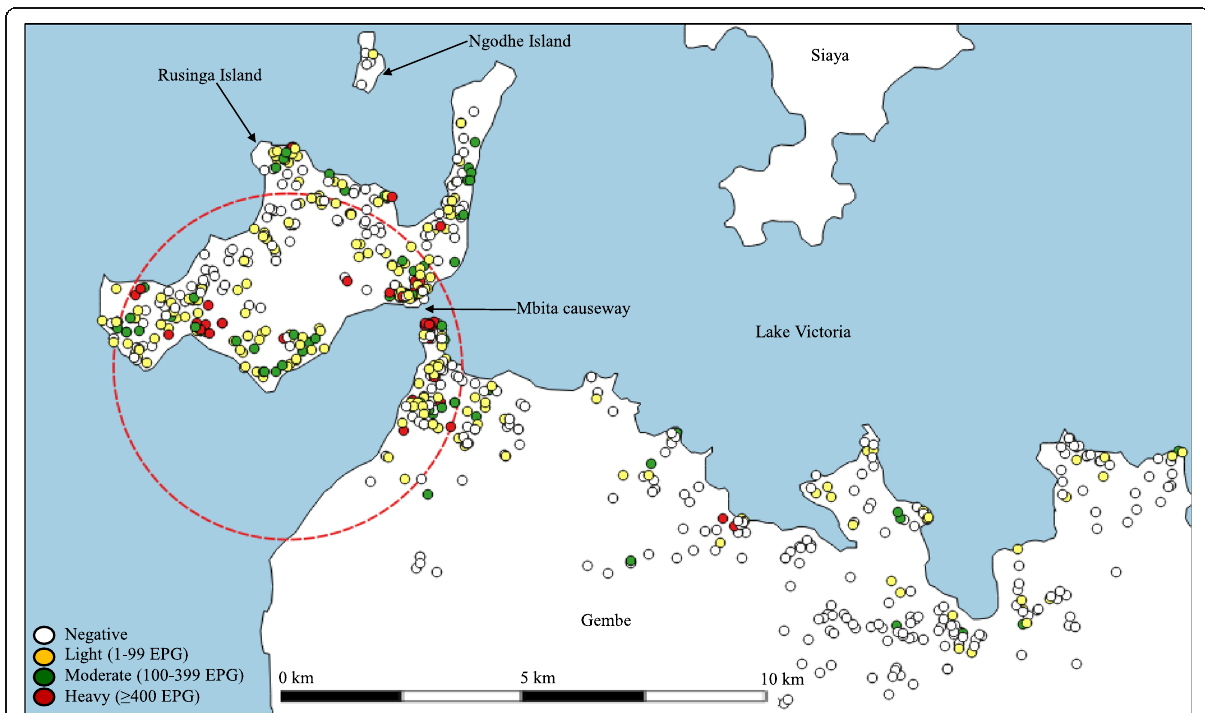
Fig. 1 High-intensity cluster of S. mansoni infection among preschool children in Mbita, western Kenya. The small white, yellow, green, and red dots depict the location of negative, light, moderate, and heavy cases respectively. The red dotted circle shows the S. mansoni infection high-intensity